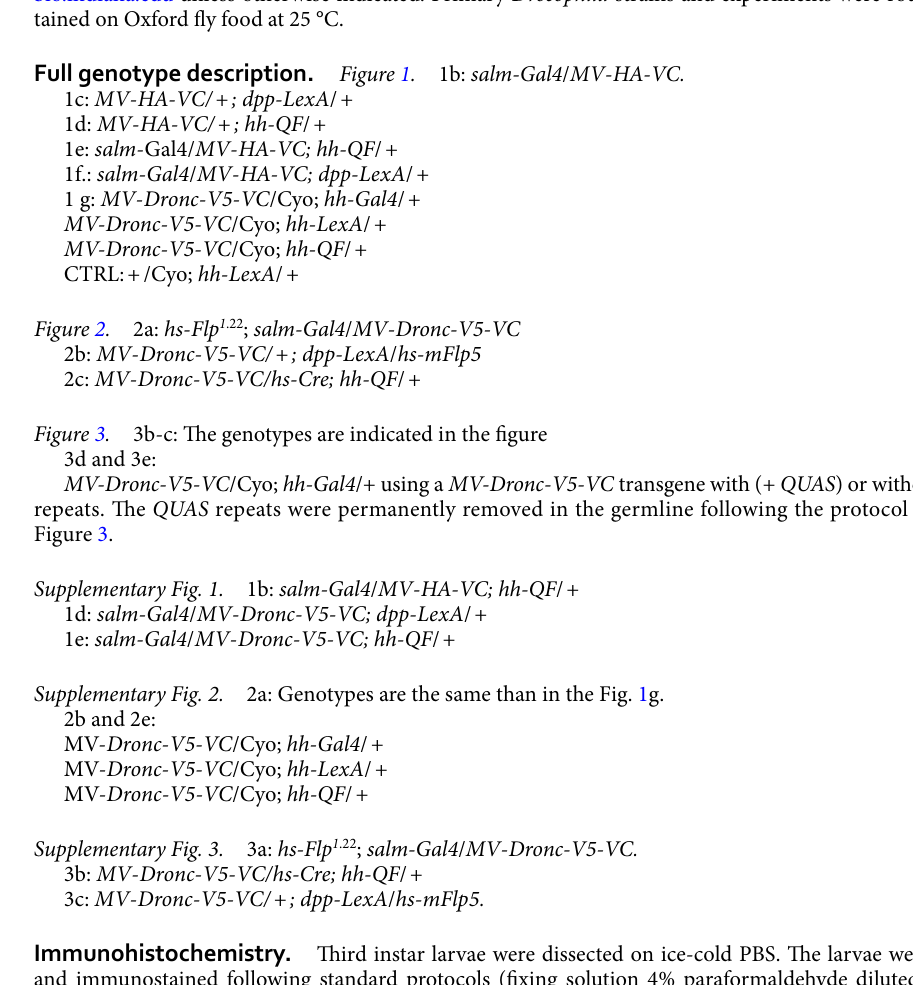
Supplementary Fig. 3. 3a: hs-Flp 1 .22 ; salm-Gal4 / MV - Dronc-V5-VC. 3b: MV - Dronc-V5-VC/hs-Cre; hh-QF / + 3c: MV - Dronc-V5-VC/ + ; dpp-LexA / hs-mFlp5.